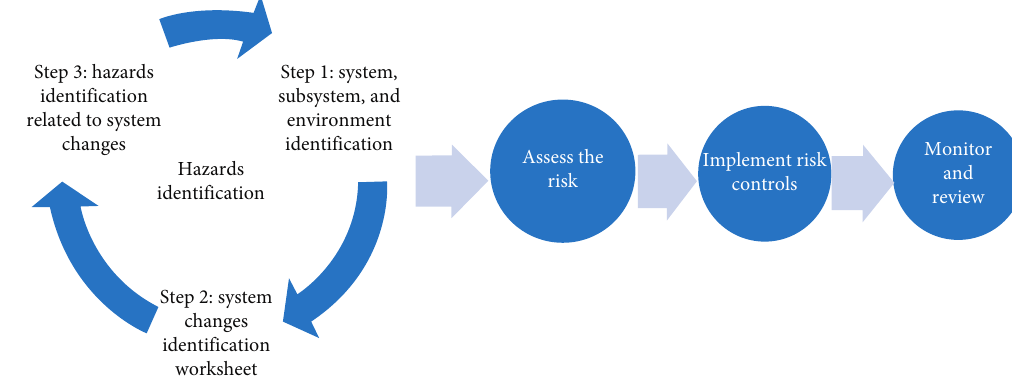
Figure 3: Three-step hazard identification approach in the SCOHI